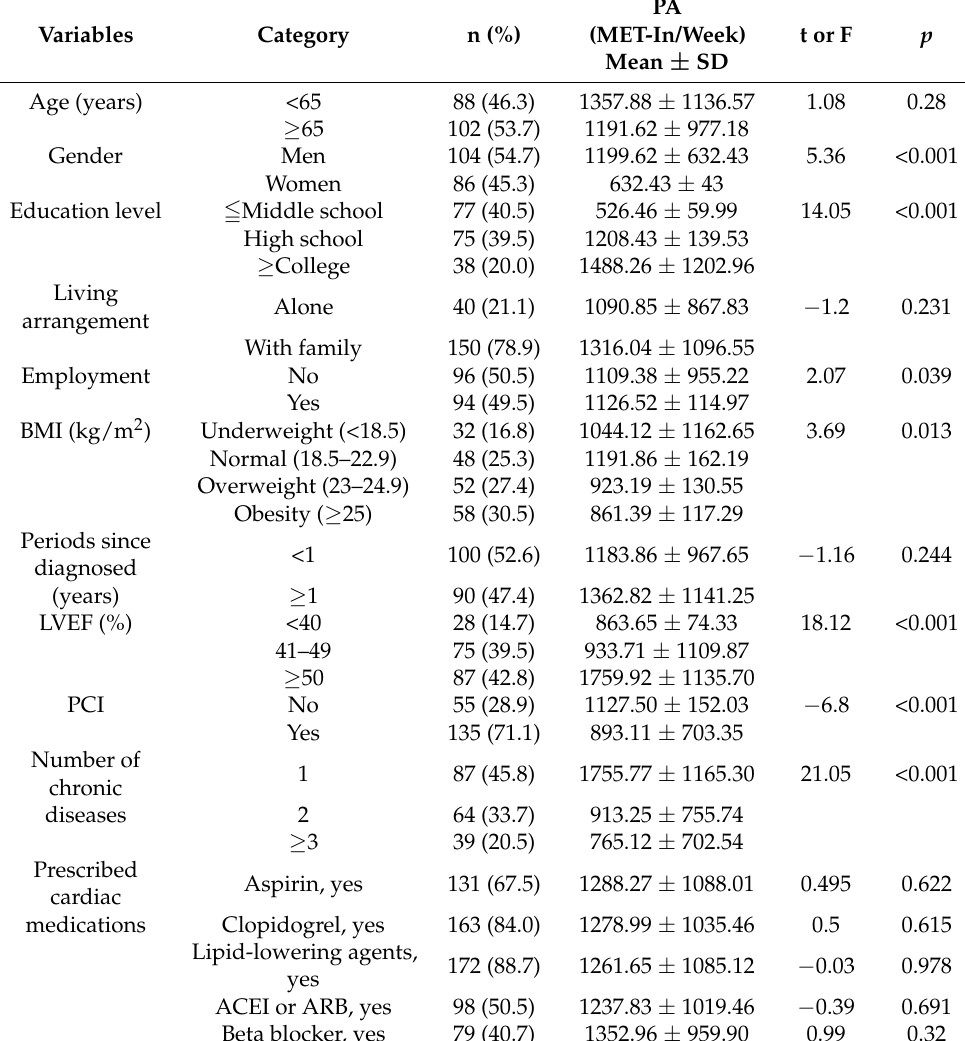
Table 1. Differences in physical activity according to sociodemographic and clinical characteristics (N =